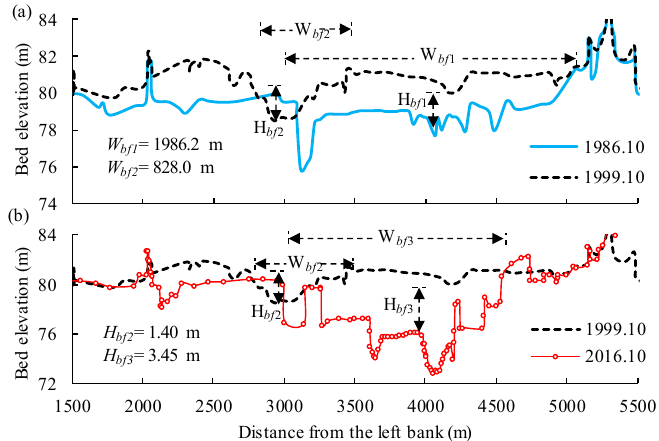
Figure 3. Temporal variations in the cross-sectional profile at the Liuyuankou section: ( a ) during the period 1986–1999; and ( b ) during the period 1999–2016.